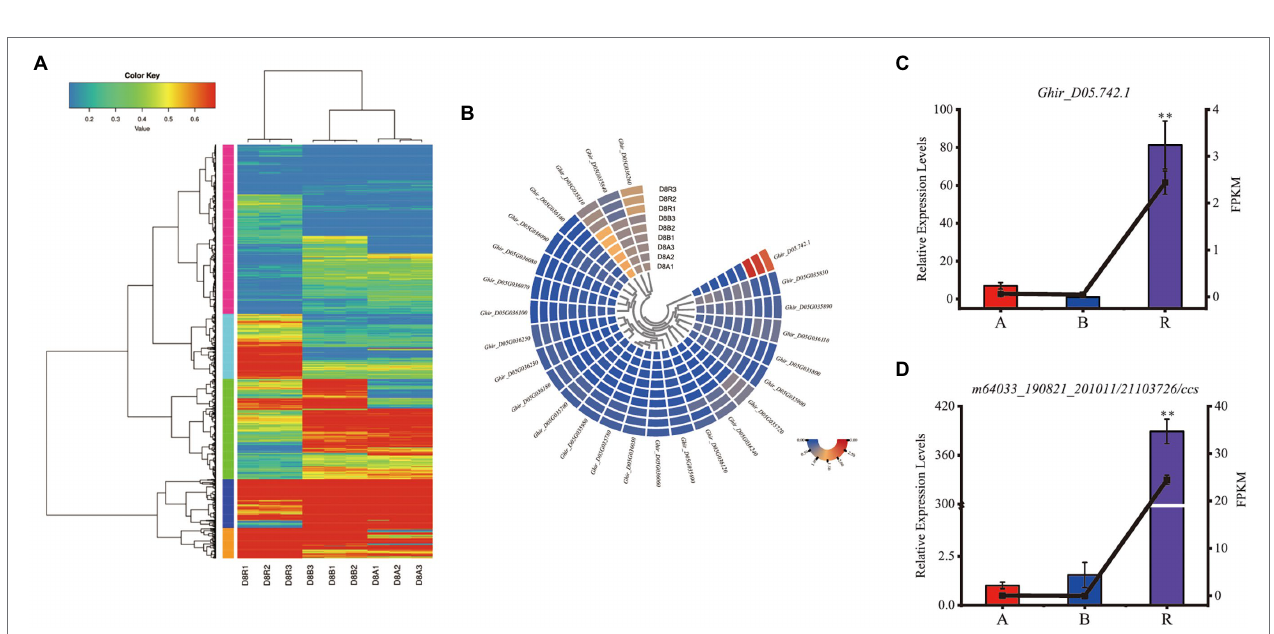
FIGURE 7 | APA analysis predicted by the PacBio Sequel platform. (A) The distribution of poly-A sites per gene. (B) Nucleotide distribution around poly-A cleavage sites.